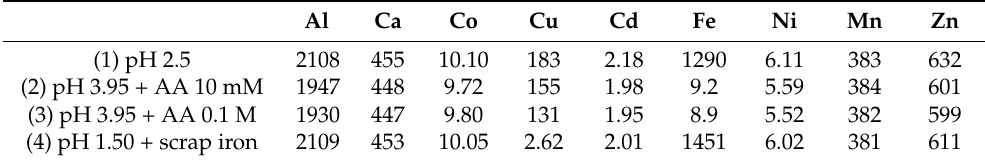
Figure 6. Scanning electron microscopy (SEM) images of metallic copper obtained in batch reduction experiments with Cu(II)-rich acidic solutions and Fe[0] (scrap iron) as reducing agent at pH 1.5. ( a – c ) sample TI; ( d – f ) sample CA; ( f ) is a BSE image of Cu[0] spheroids. Table 2. Concentration of selected dissolved metals (in mg/L) in acidic mine water samples from TI after several Cu 2+ reduction